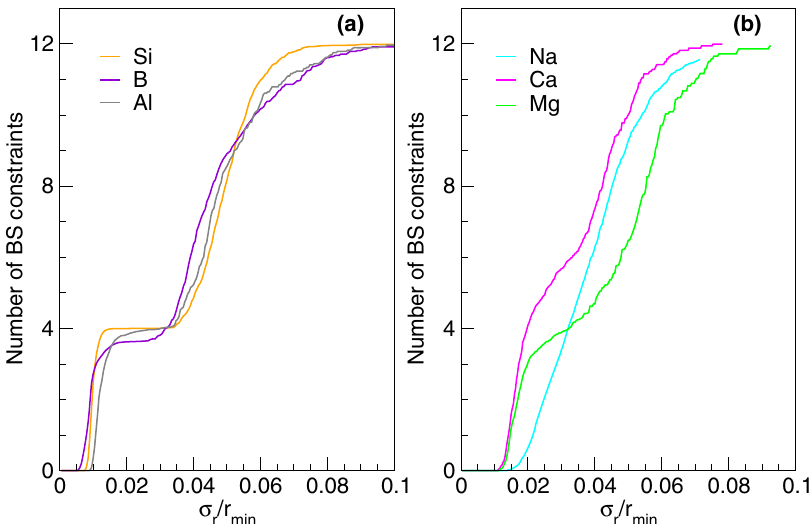
Fig. 4 Number of BS constraints for the different species in the N19M8 glass, with addition from Ca contribution from the N19C8 glass, as a function of a rescaled radial standard deviation. a Displays network formers while b displays network modi fi er. The values r min are derived from the corresponding minimum of each partial pair correlation function reported elsewhere 56